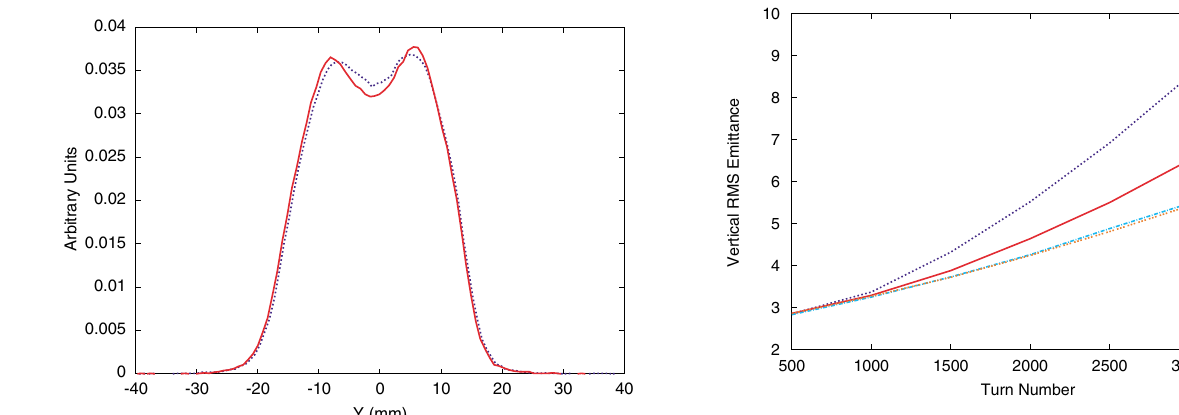
FIG. 12. (Color) Experimental transverse vertical profile mea- surements of the half intensity beam. The (blue) dashed curve is the profile of the beam without the longitudinal notch, and the (red) solid curve is the profile of the beam with the longitudinal notch.